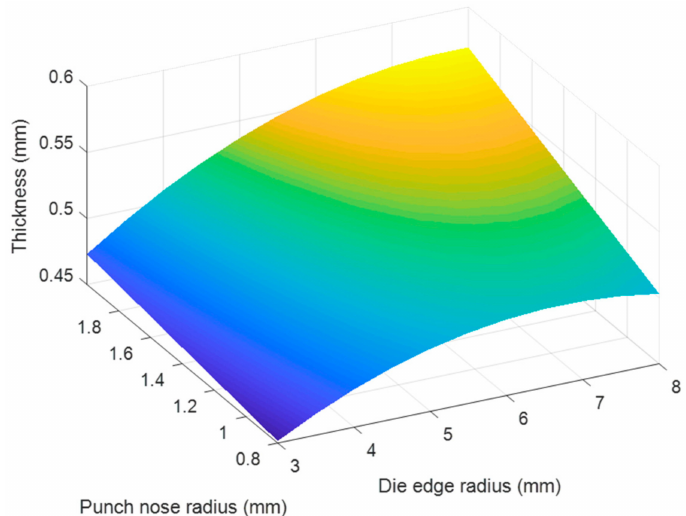
Figure 20. The effect of punch nose radius and die edge radius on thickness.